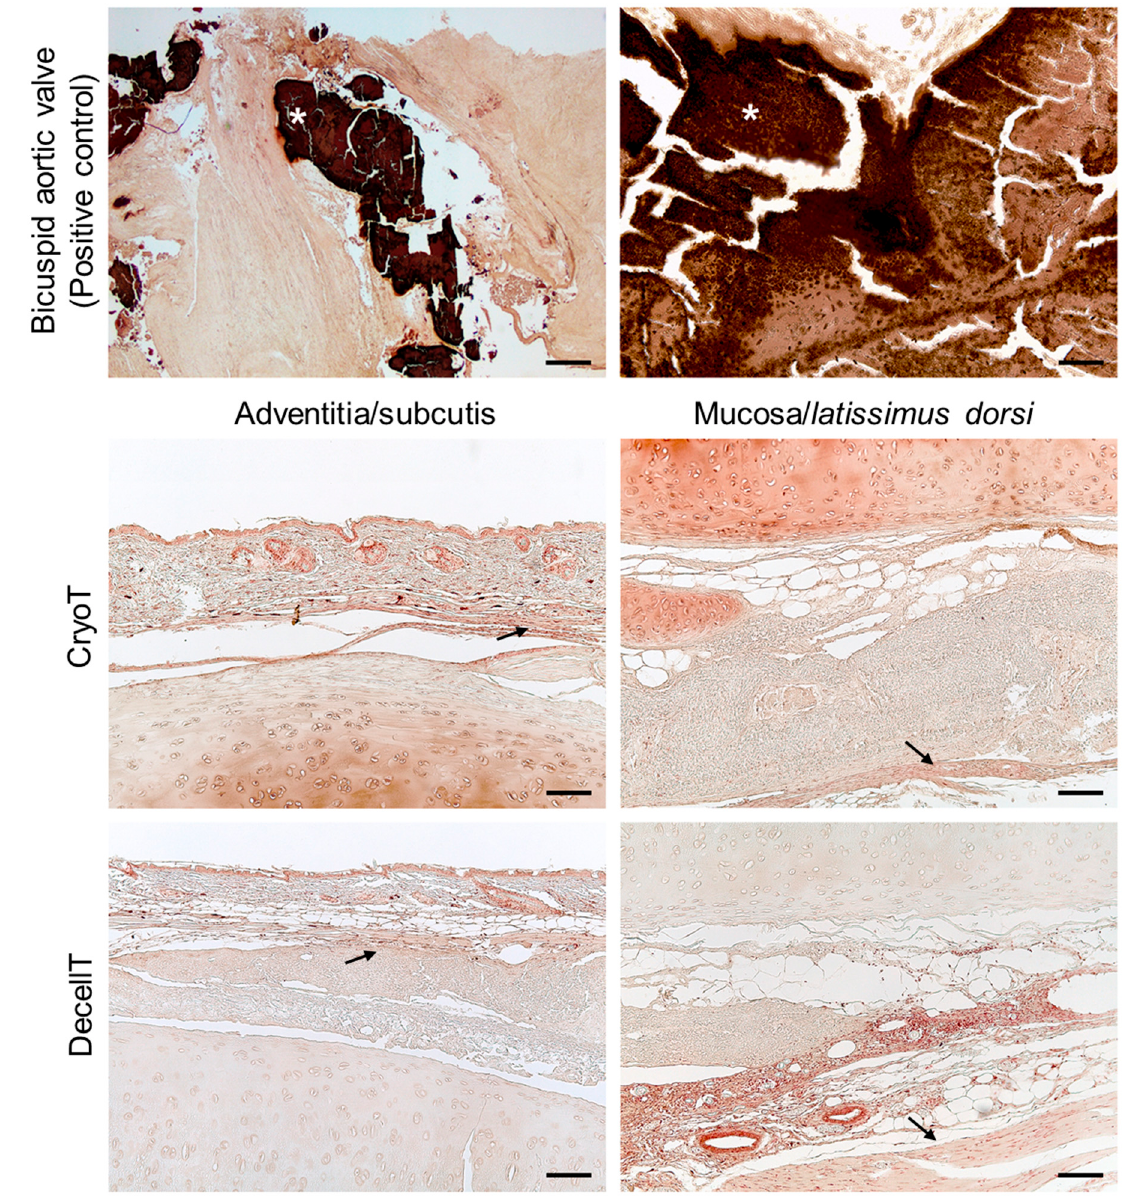
Figure 15. Histological characterization of the CryoT and DecellT explants by von Kossa staining. Both the mucosa/submucosa side and adventitia, in contact with the subcutis and the latissimus dorsi, respectively, were focused (the back arrow shows the interface) (scale bars: 100 µm) A positive control (calcification of bicuspid aortic valve, white asterisk (*)) was included in the first row (scale bars from the left to the right: 100 µm; 50 µm).